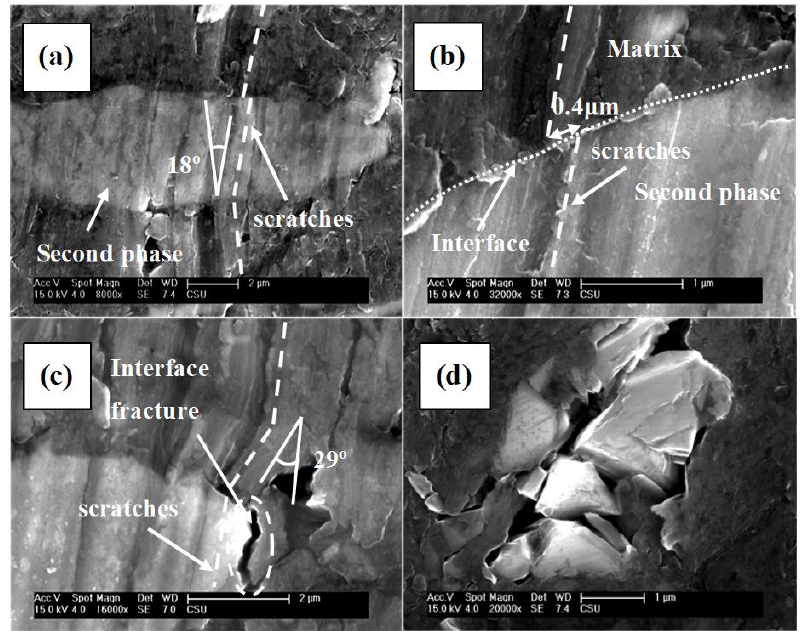
Figure 6. The SEM images in the secondary electron mode of near-CSPs regions after the sample was cold-rolled at 10%: ( a ) a scratch deflected by ~18° when it crosses the CSP; ( b ) a scratch displaced by about 0.4 μm at the CSP interface; ( c ) cracks nucleated at the CSP interface; ( d ) fracture of CSP.